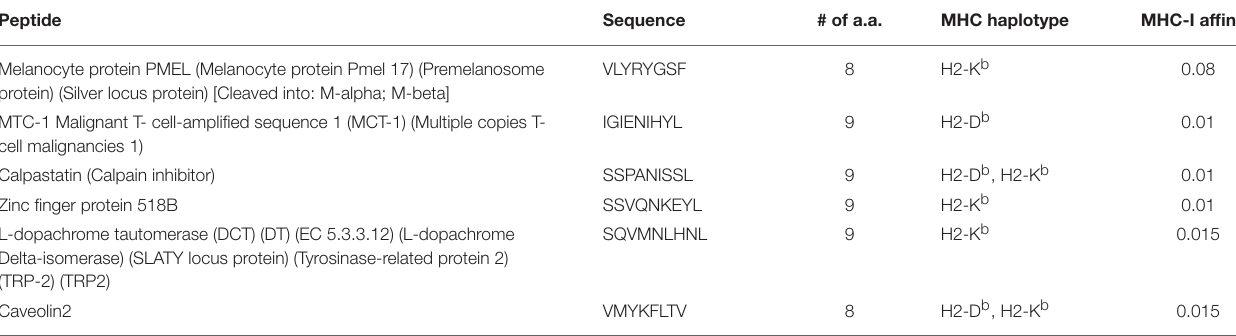
TABLE 2 | The selected peptides from immunopeptidomics for the generation of germline-MTV. Peptide Sequence # of a.a. MHC haplotype MHC-I